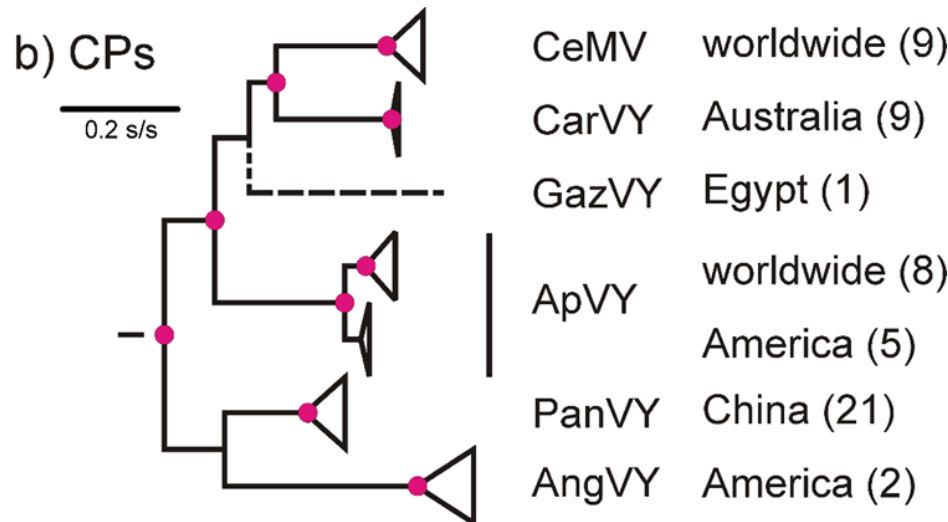
Figure 1 . ML phylogenies of: ( a ) the non-recombinant complete ORFS (COs) of the two lineages of potyviruses that were analysed; ( b ) the coat protein (CP) genes from the COs together with those downloaded from Genbank; the total number of sequences contributing to each ‘ collapsed ’ cluster in parentheses. Abbreviations: AngVY, angelica virus Y; ApVY, apium virus Y; AshMV, ashitabi mosaic virus; CarVY, carrot virus Y; CeMV, celery mosaic virus; CaTLV, carrot thin leaf virus; GazVY, gazar virus Y; KonVY, konjac virus Y; PanVY, panax virus Y. The partial ORF from sample 21625530, was of nts 928–1249 and 5860–6309 of the other sequences, and when these regions were compared, they showed the isolate to be closest to MT900482. The Gazar virus Y partial CP gene (GQ148776) was of 320 nts from the centre of the CP gene, and it was placed in the phylogeny using a phylogeny calculated using only the homologous region of all 80 other CP genes.